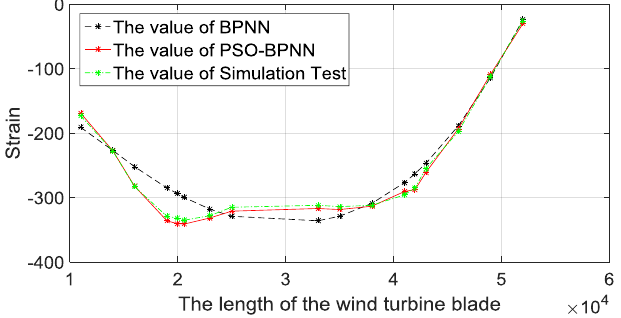
Figure 11. Comparisons of BPNN methods with the FEA.